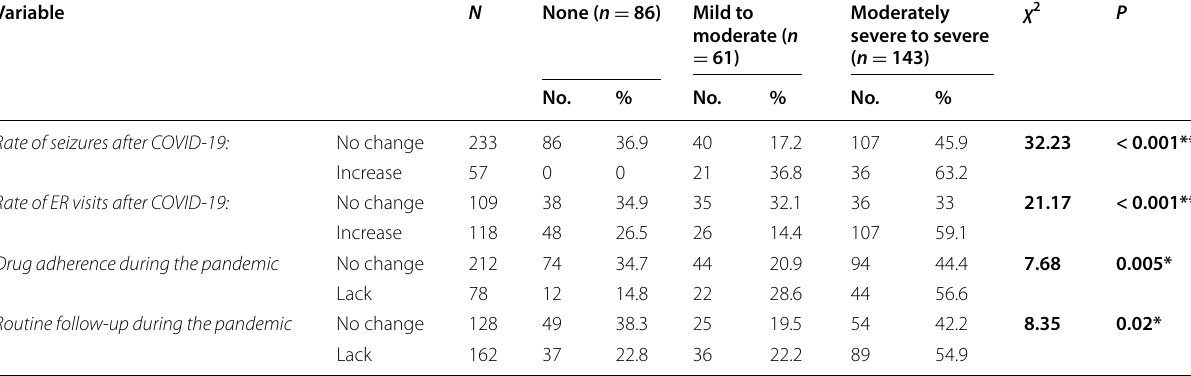
Table 5 The relationship between depression and epilepsy during the pandemic among the studied